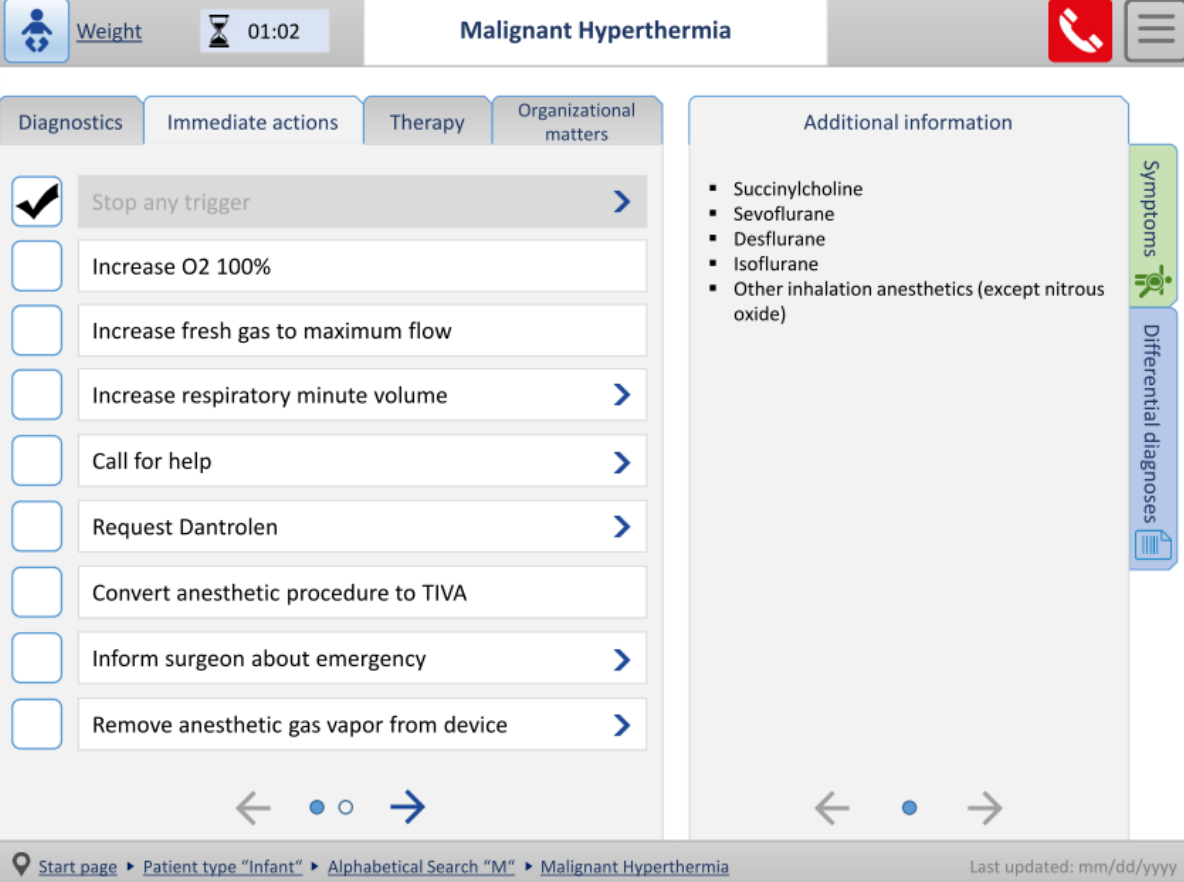
First Prototype: Web-Based Questionnaire Sample description: A total of 12 anesthesiologists